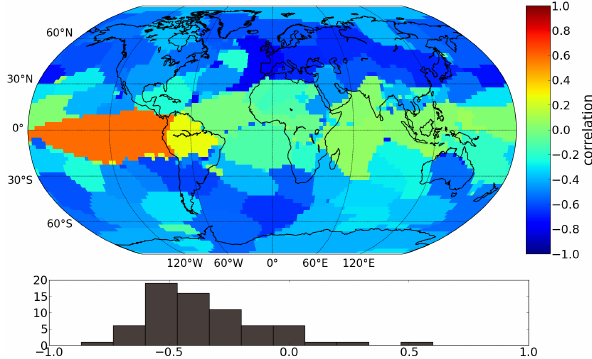
Fig. 15. Regions that show high relevance for the global graph evo- lution, when the intra-regional graph threshold at each time point is set equal to the global 2562-node grid graph with density 0.005. Visualisation as in Fig.